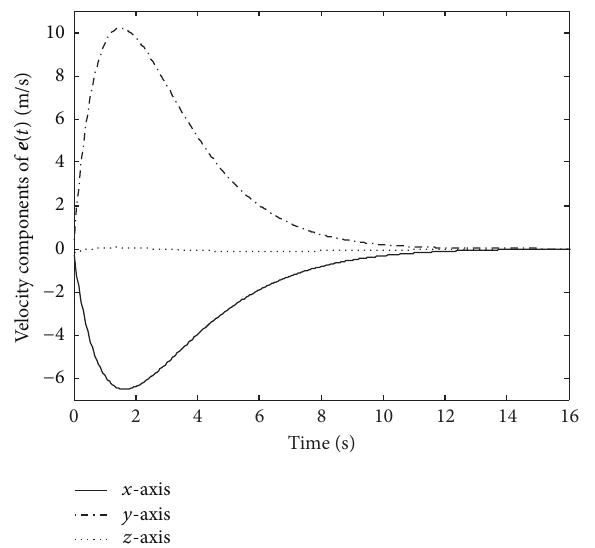
Figure 2: Velocity components of the error vector e (𝑡)